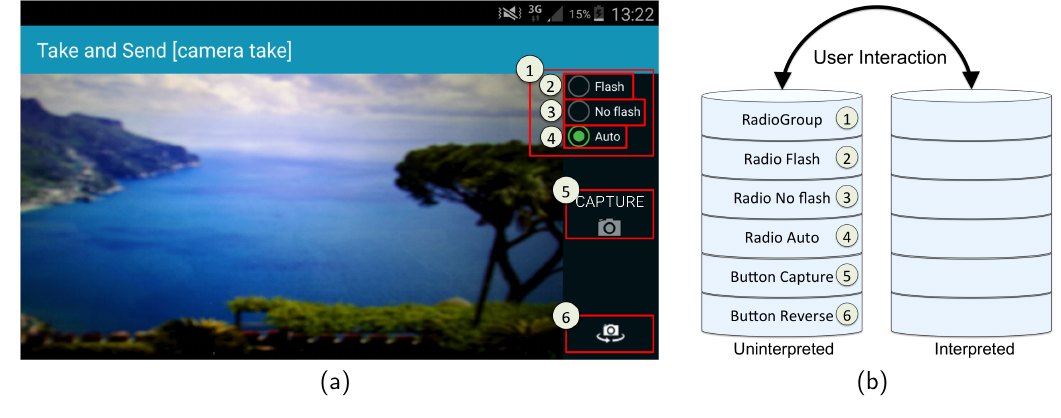
Figure 4. Two MicroApp design